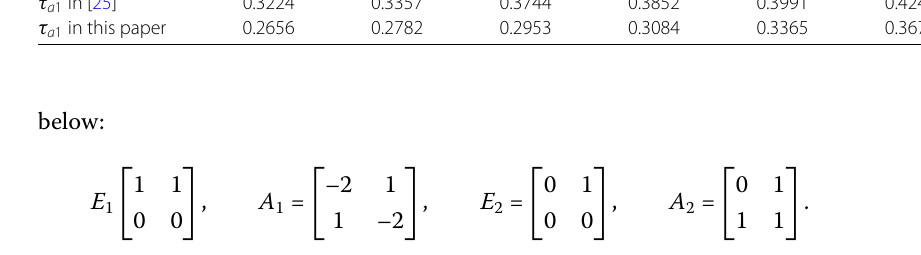
Table 1 Comparisons of τ a 1 between [25] and Theorem 3.2 α